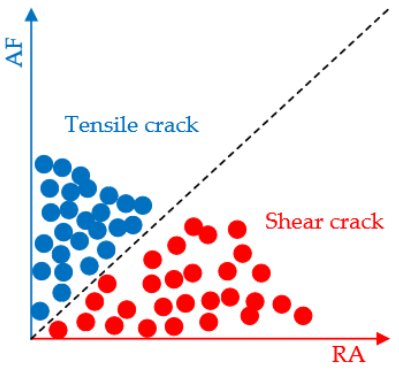
Figure 7. The crack classification based on RA and